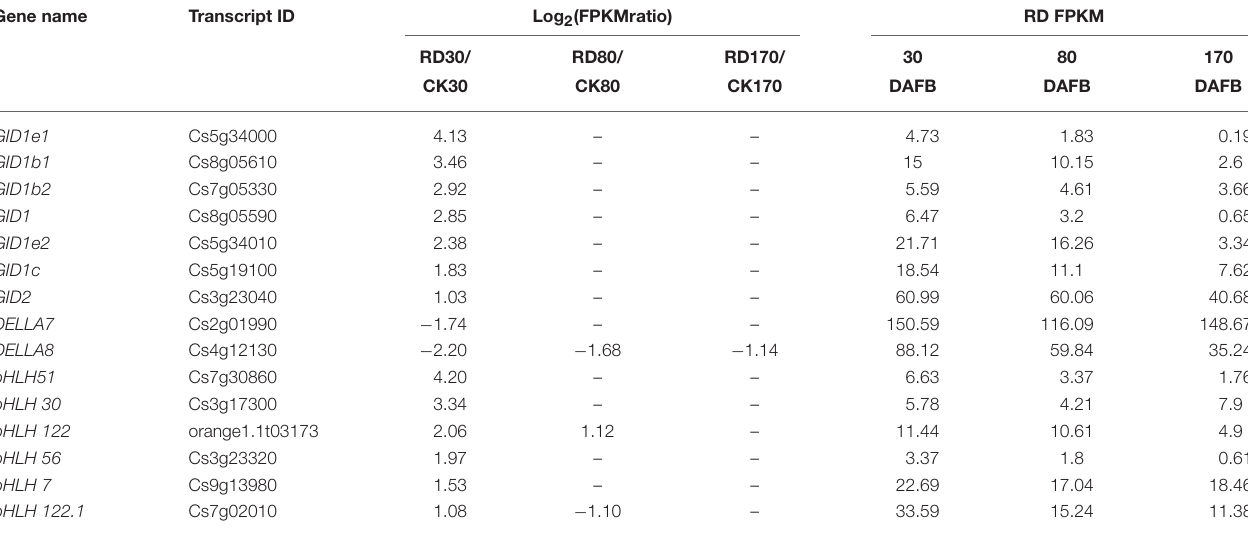
TABLE 5 | List of important DEGs initially responding to peel roughing